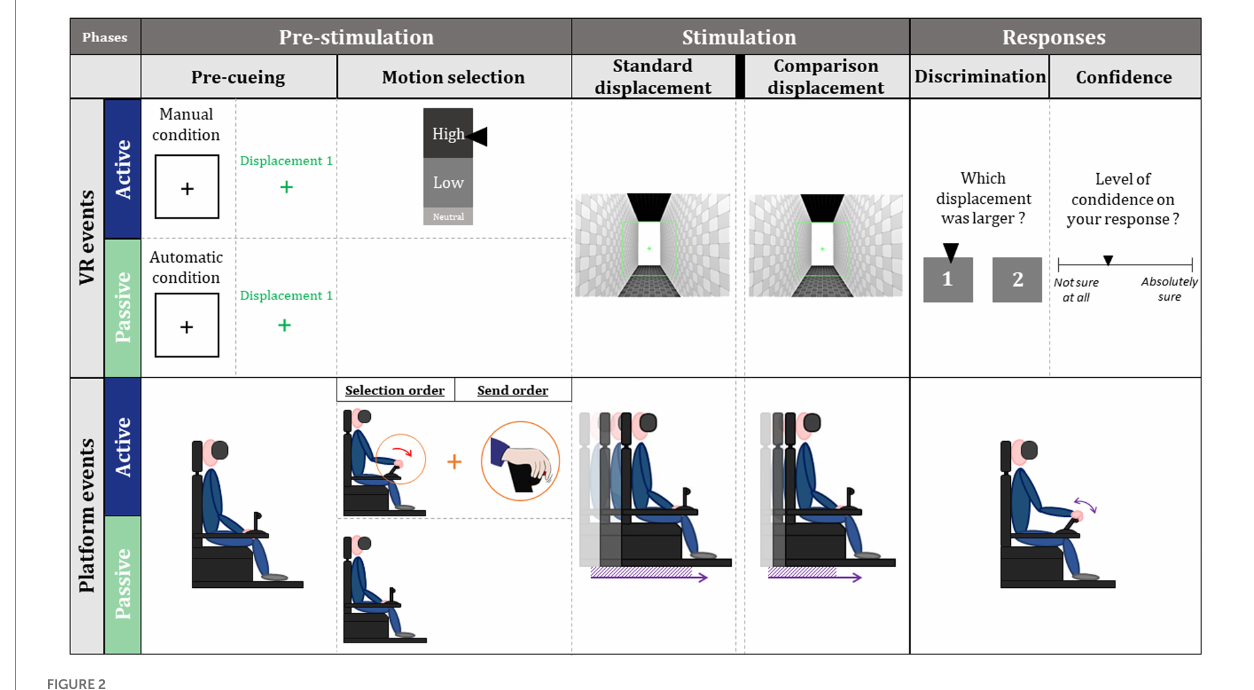
FIGURE 2 Schematic representation of the different phases of a